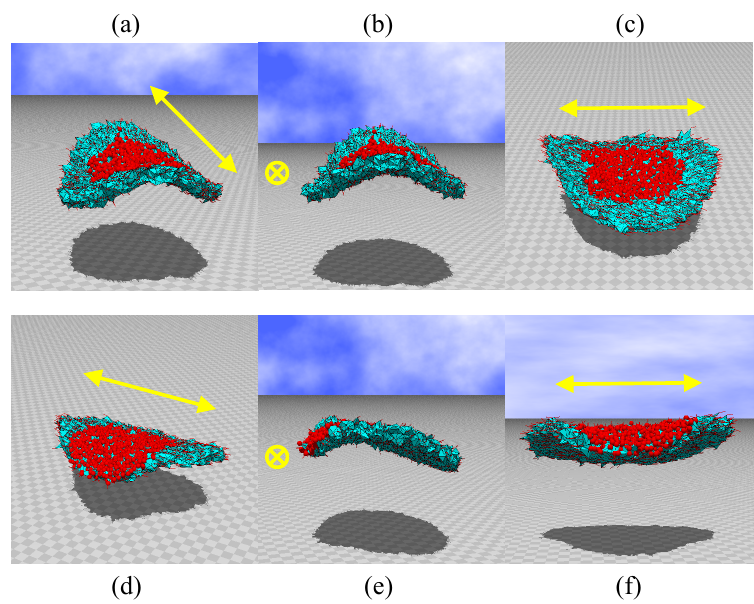
Figure 7. ( a – c ) Snapshots of disks irradiated by light at the central region, and ( d – f ) those irradiated at the region between the center and edge. The original disk size is D / H = 16 (see Figure 2b). The parameters are κ = 0.5 and λ = 2.4. N = 10,980.